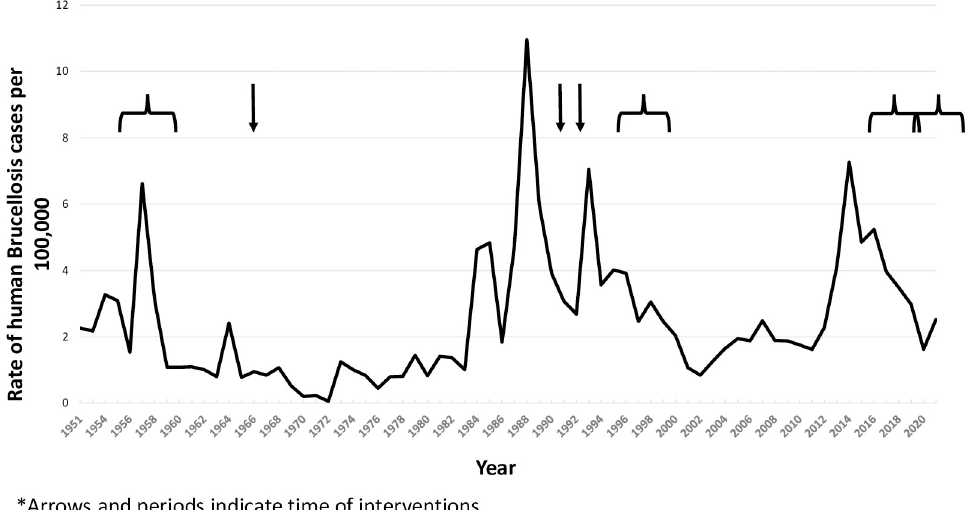
Fig 1. Reported human cases of brucellosis in Israel, rates per 100,000 and period of interventions, 1951–2021. � Arrows and periods indicate time of interventions